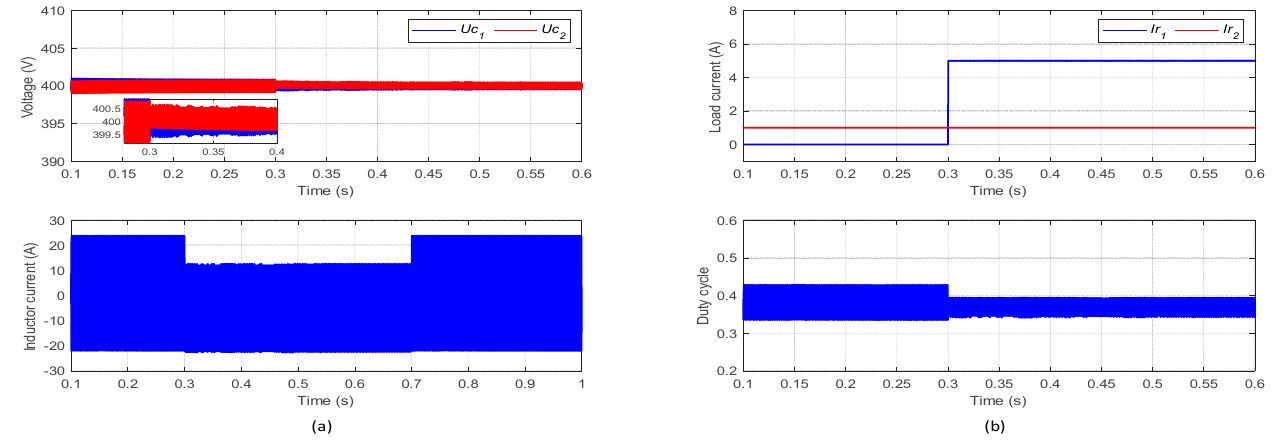
Figure 13. Numerical results with 50% inductance nominal value using the GA–PI controller. ( a ) Inductor current and output voltages. ( b ) Duty cycle and load current.